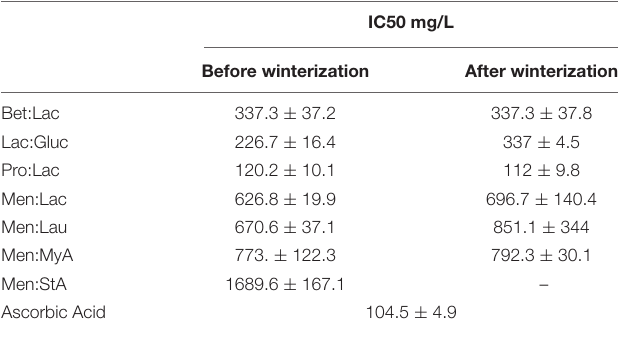
TABLE 6 | The IC50 values of DPPH scavenging effect of hemp extracts (mg/L).